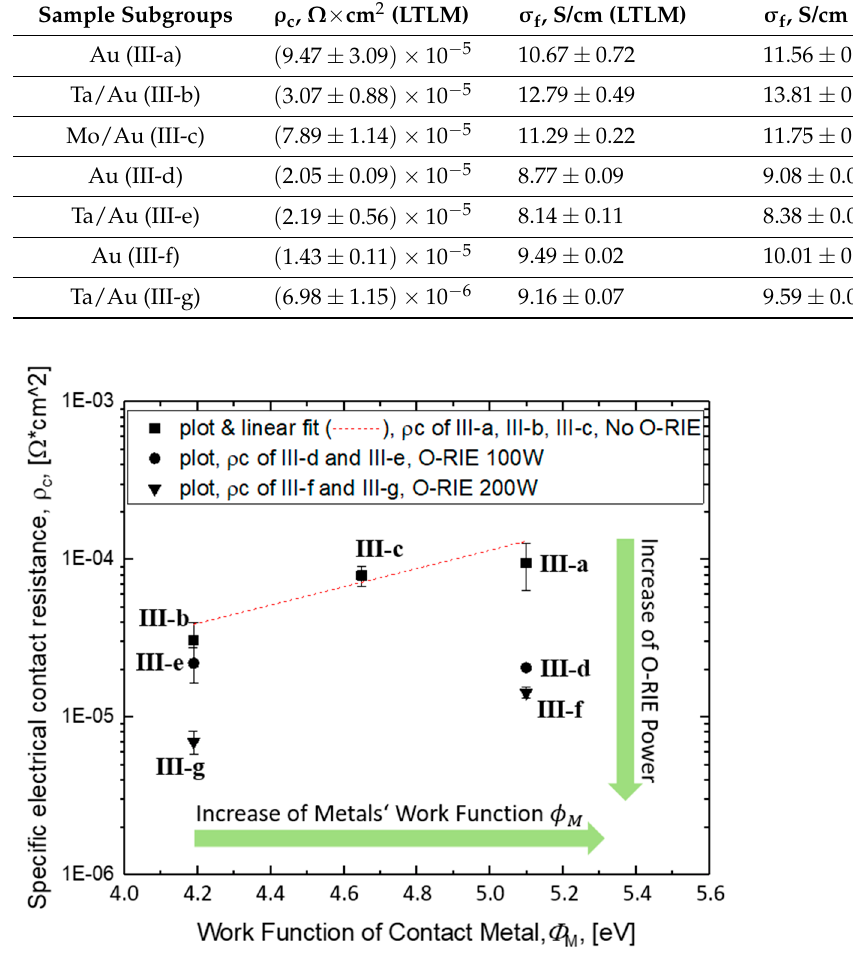
Figure 6. Specific electrical contact resistance (in Ω cm 2 ), regarding different contact metals’ work function and O-RIE process power. function and O-RIE process